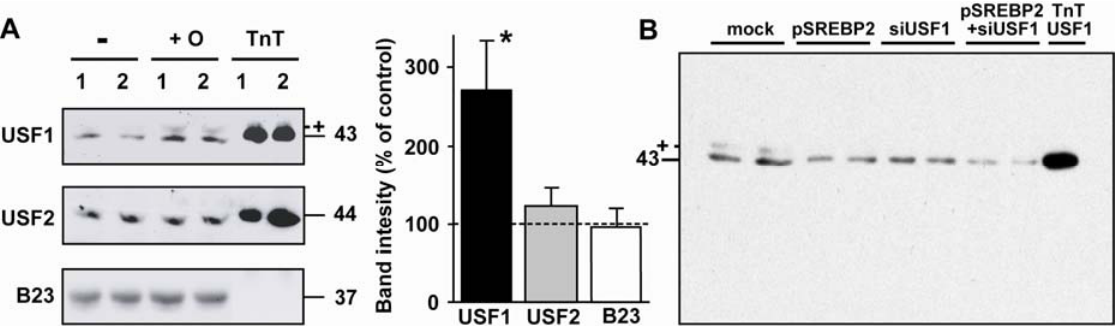
Figure 7. Effect of oleate and nSREBP2 on nuclear USF1 protein abundance. (A) HepG2 cells were incubated for 48 h in the absence (-) or presence (+O) of oleate. Thereafter, nuclear extracts were prepared and used for immunoblotting. B23 protein served as internal control. TnT 1 and 2 are 0.5 and 1.0 μ L, respectively, of in vitro made USF protein (left panel). The data were quantified by densitometry and expressed as percentage of control (right panel; n = 3–4; *: P < 0.05 vs. control). (B) HepG2 cells were transfected without (mock) or with 100 ng pSREBP2, siUSF1, or both. Nuclear extracts were immunoblotted with anti-USF1. The molecular sizes are indicated in kDa. The bands marked with + may represent a modified form of